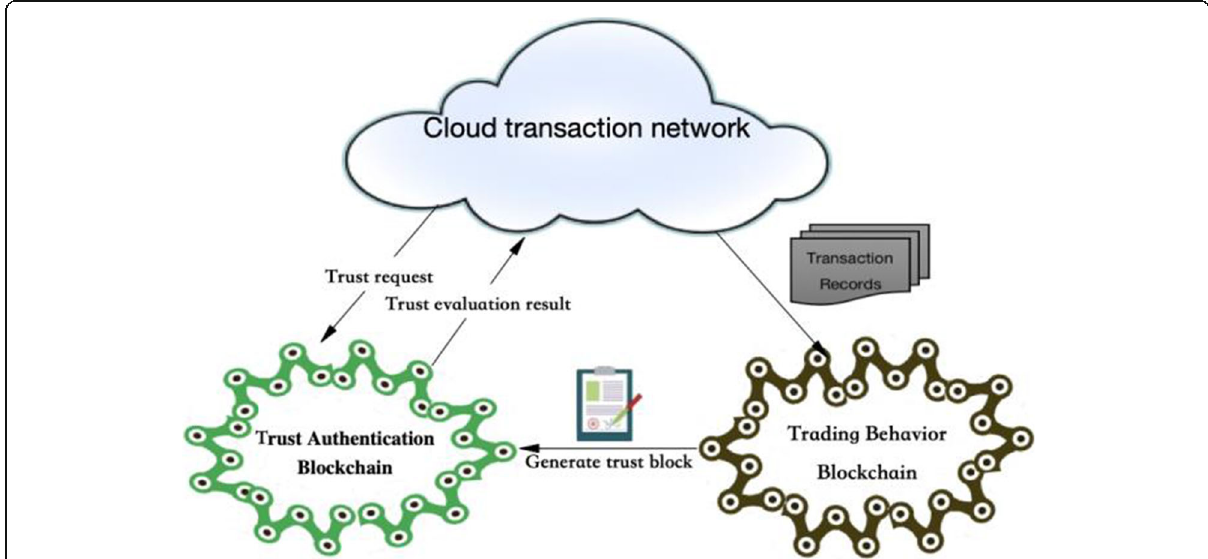
Fig. 22 Cloud service transaction model based on a double-blockchain structure